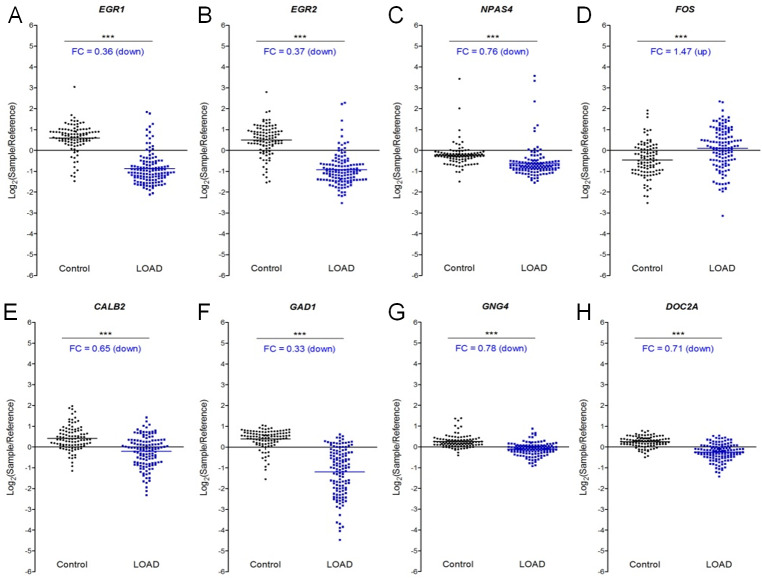
Biomarkers modulated by ORY-2001 are differentially expressed in LOAD.Re-examination of the expression of the orthologues of SAMP8 biomarkers in human prefrontal cortex in Control and LOAD samples from NCBI GEO GSE44770 [44] reveals differential expression of immediate early genes (A) ERG1, (B) ERG2, (C) NPAS4 and (D) FOS, (E) CALB2, (F) GAD1, (G) GNG4 and (H) DOC2A. Control: N = 101, average age 62.1 years, male to female ratio = 4.3; LOAD: N = 129 subjects, average age 80.1 years, male to female ratio = 0.9. All samples are represented as Log2 (sample/reference sample) calculated from GSE44770 data. Mean ± SD are represented. Fold changes (FC) were calculated as 2^[average Log2(LOAD/Reference values)–average Log2(Control/Reference values)]. Normality was verified by D'Agostino & Pearson omnibus normality test. If data passed the normality test statistical significance was calculated by unpaired t-test, otherwise the Mann-Whitney test was applied. *p < 0.05, **p < 0.01, ***p < 0.001.